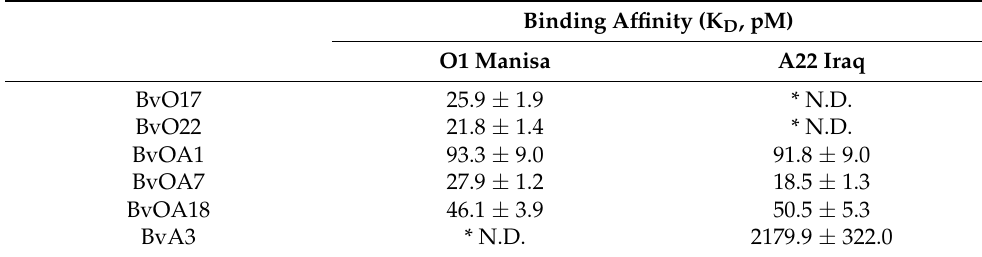
Table 2. Binding affinity of selected scFv clones. Asterisks (*) are not